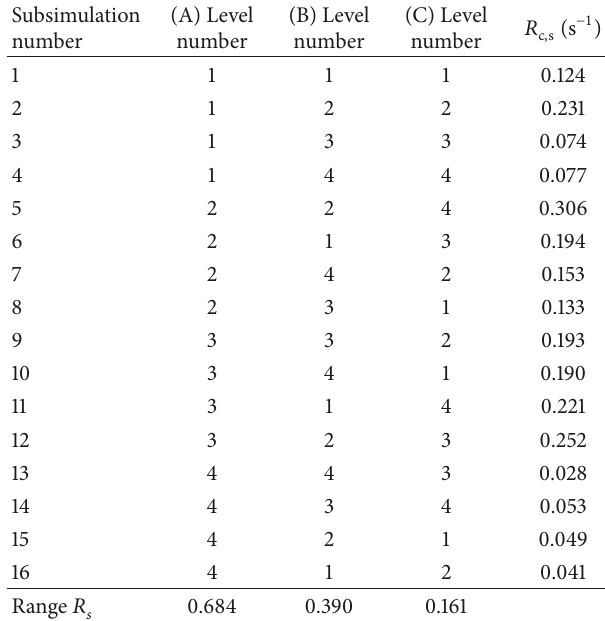
Table1:Materialmechanicalparametersofthetroughandparticles.